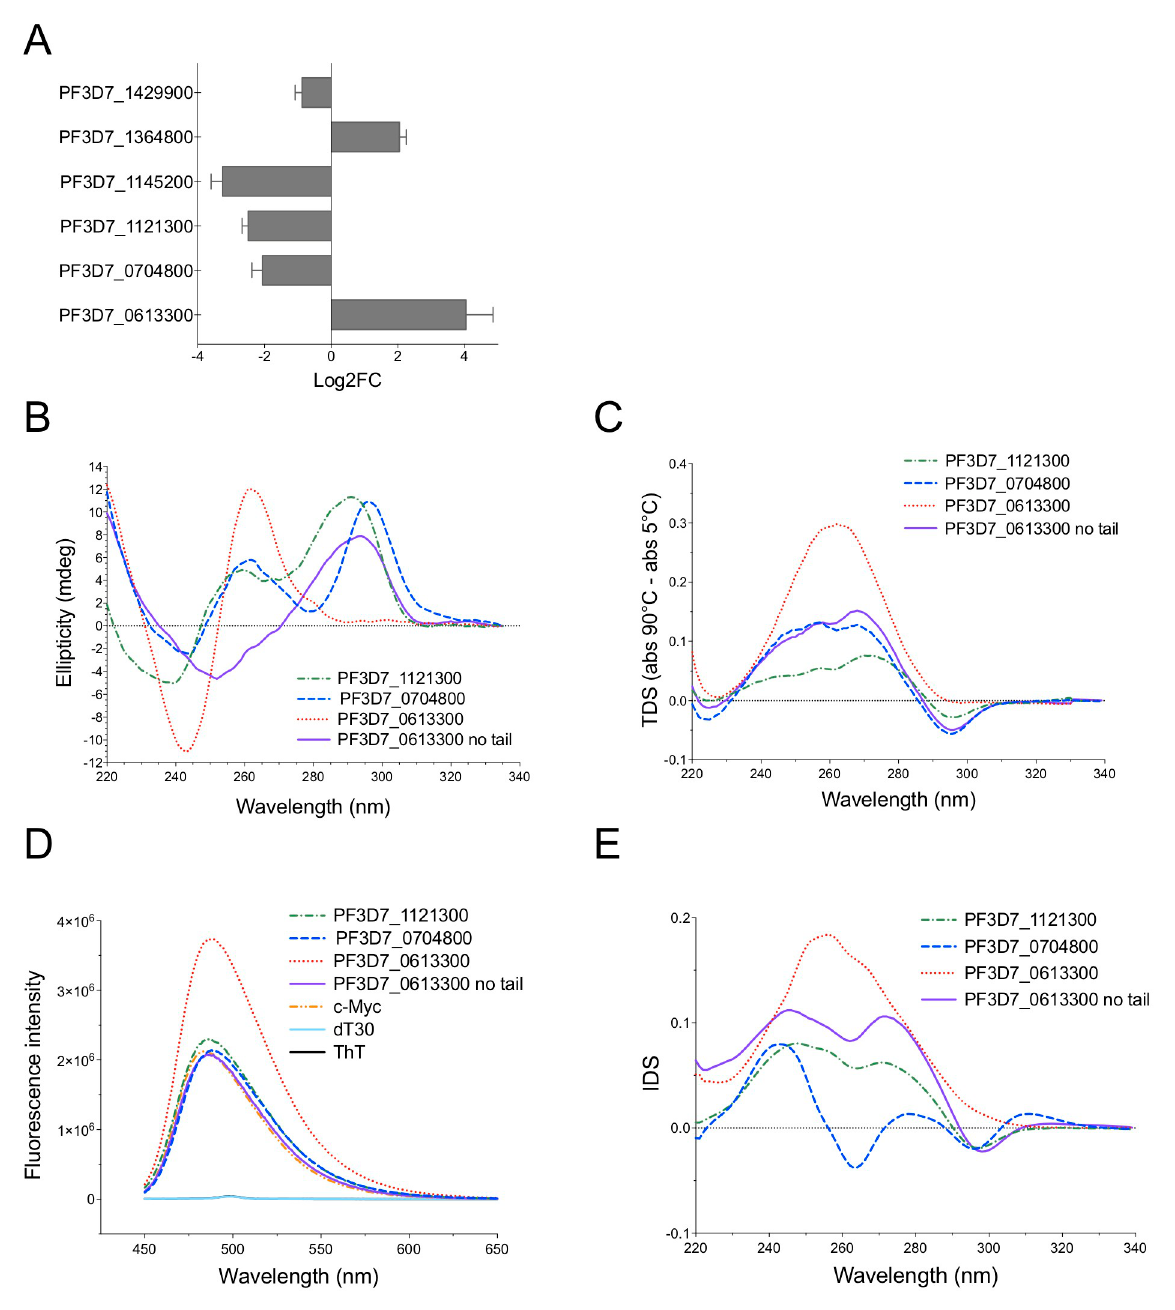
Fig 9. Validation of RNA-Seq data by qRT-PCR and biophysical characterization of selected G4FS. (A) Relative expression of selected target genes expressed in log2 Fold-change (Log2FC). Error bars correspond to the standard deviation of the ΔΔ C T value. (B) CD spectra of four promoter G4FS. For PF3D7_0613300-no-tail, an 8-nt 5’ tail has been removed. The G4 oligonucleotide sequences are shown in Table 3. (C) Thermal difference spectra (TDS) of selected G4FS. For CD and TDS, DNA samples were folded at 20˚C in 100 mM KCl at 6 μ M, except PF3D7_0613300 with and without tail, which have been folded at 3 μ M at 5˚C. (D) Fluorescence emission spectra of ThT in the presence of selected G4FS. The c-Myc and dT30 sequences were used as positive and negative controls, respectively. (E) Isothermal difference spectra (IDS) of the four promoter